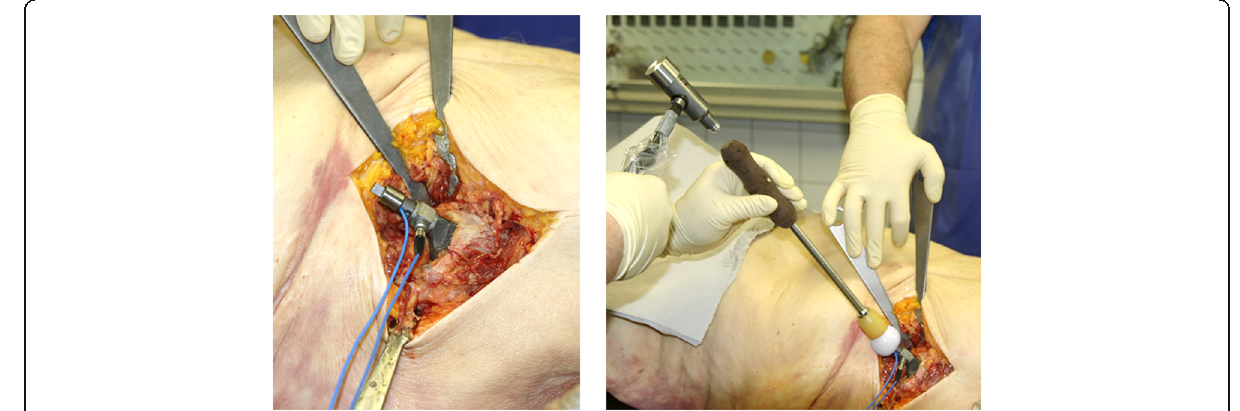
Fig. 2 Left: Implanted measuring stem; right: Setup to measure in situ assembly